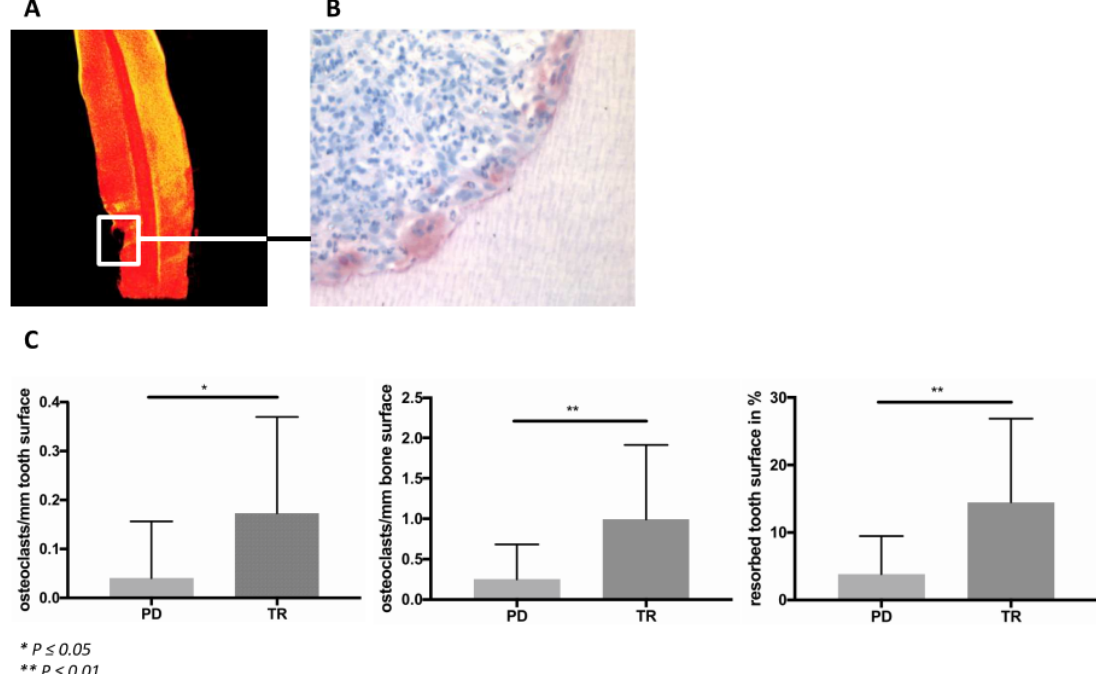
Figure 2. ( A ) Micro-Computed Tomography ( µ CT) image of a canine affected by tooth resorption (TR). The affected area is marked with a white rectangle. ( B ) Tartrate-resistant acid phosphatase staining of this tooth revealed many osteoclasts in this area, directly adjacent to the dentine of the tooth. The image was obtained at 400× magnification. ( C ) The evaluation showed significantly more osteoclasts in TR ( n = 11) compared to periodontitis (PD) ( n = 23) in both of the mineralized tissues, bone ( p ≤ 0.01) and tooth ( p ≤ 0.05). There was also a significant difference in the percentage of the eroded tooth surface between these groups ( p ≤ 0.01).